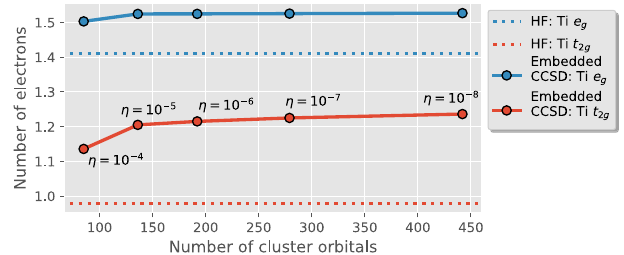
FIG. 12. Convergence of the number of electrons in the Ti e and t 2 orbitals of SrTiO 3 with respect to the number of cluster g orbitals, as determined by the bath threshold η . The dotted lines mark the respective Hartree-Fock